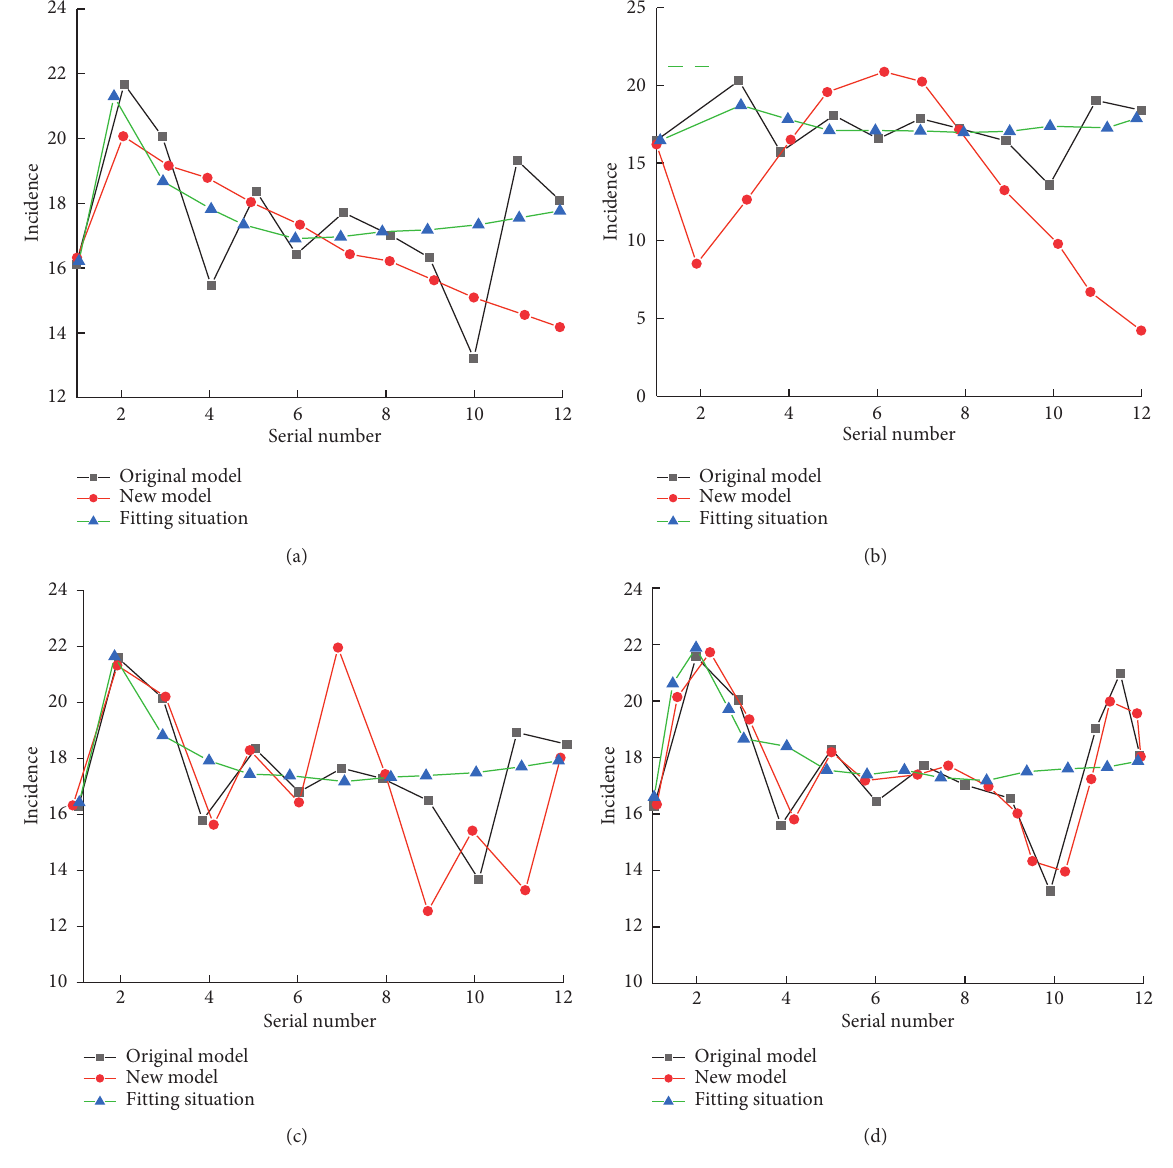
Figure 7: Comparison of simulation